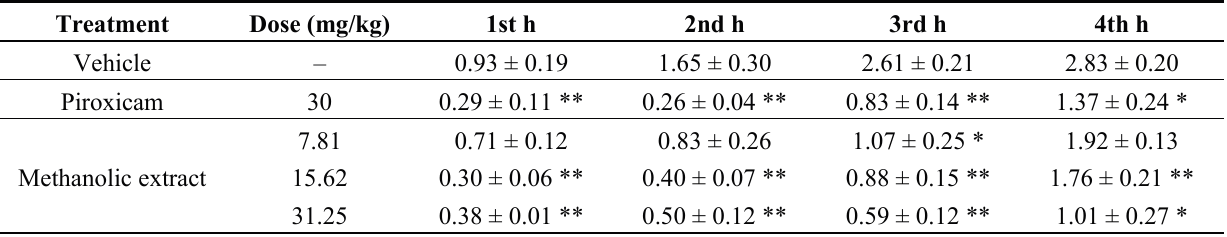
Table 1. Effects of administration of methanolic extract from Davilla elliptica leaves via the intraperitoneal route on carrageenan-induced rat paw